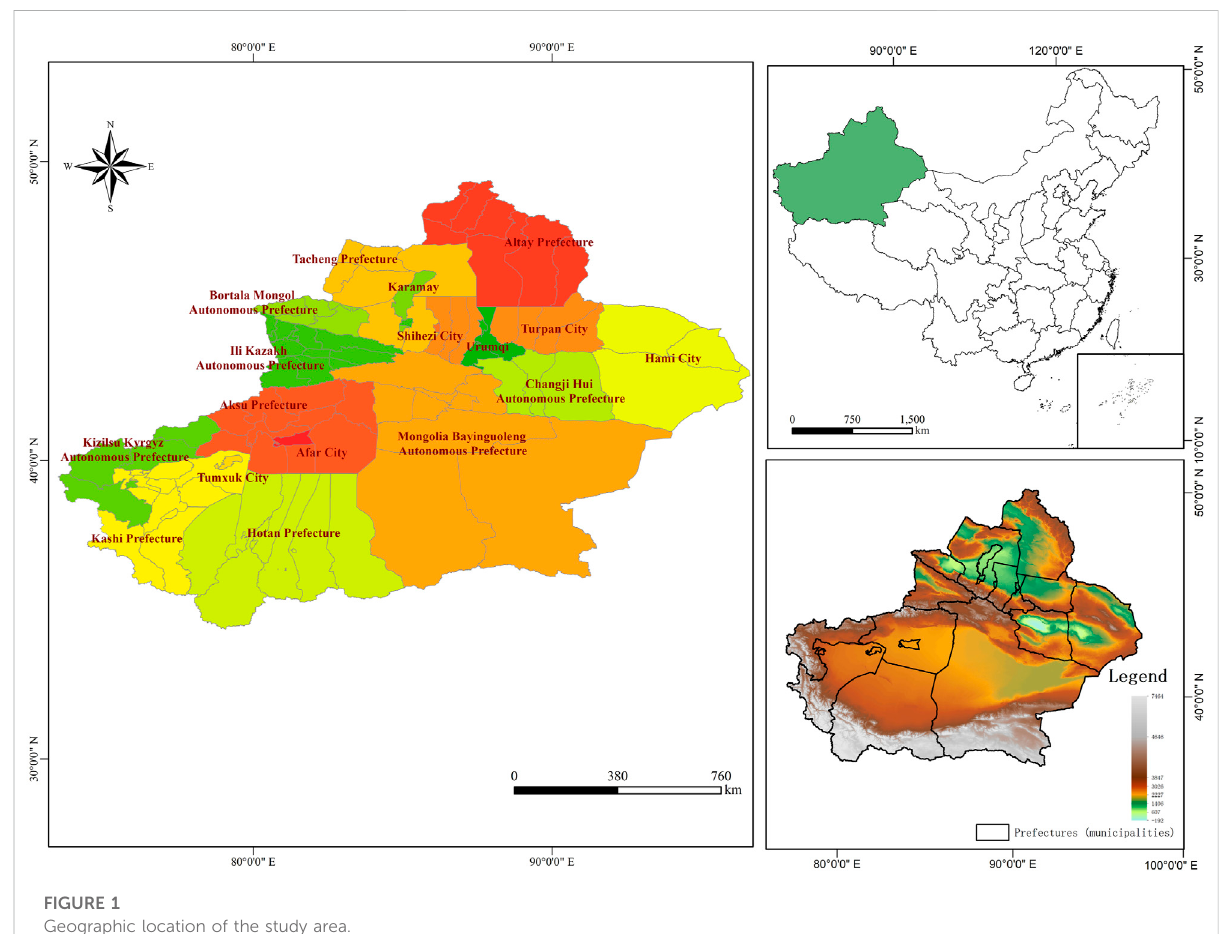
FIGURE 1 Geographic location of the study